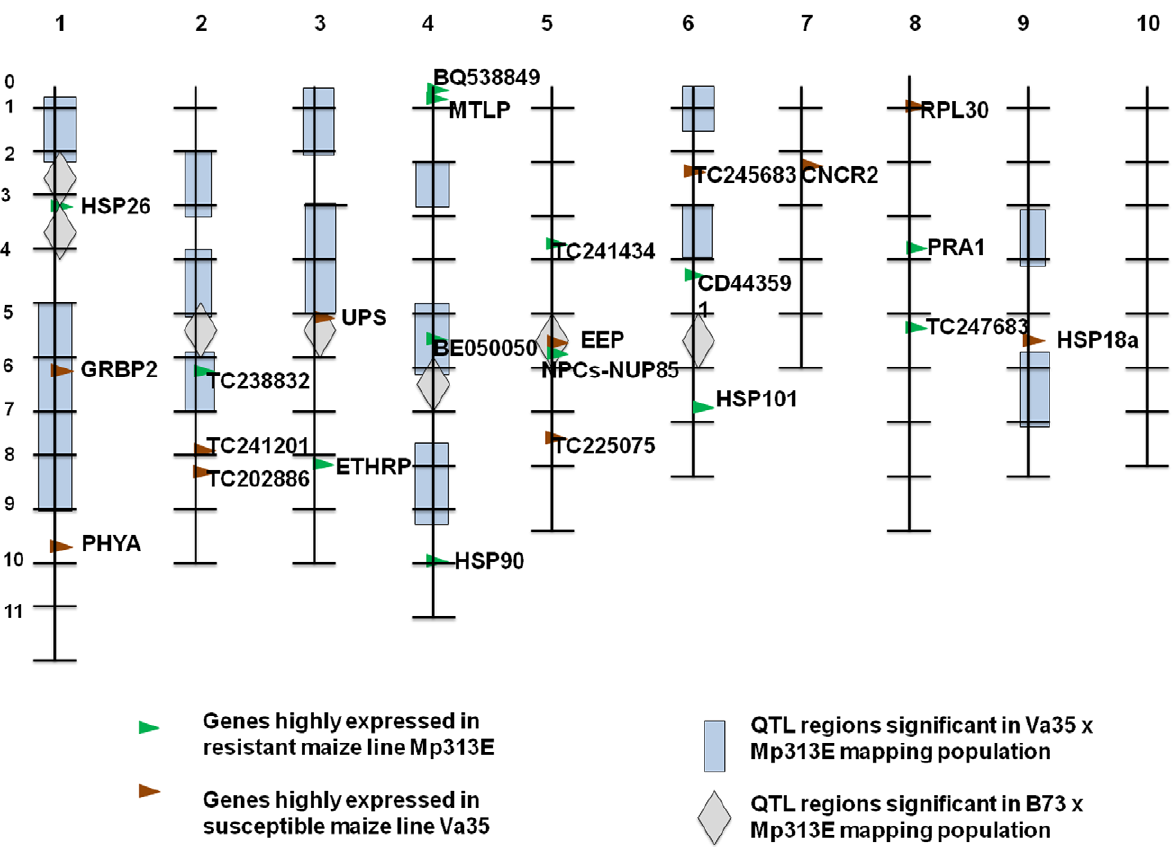
Figure 7. Chromosome bin map showing the positions of the significant genes and the previously identified QTL regions. Eight genes were mapped within or close to the seven most significant QTL regions. The top highly expressed gene in Va35, AI664980 (Chr1, bin1.06), is located in the most significant chromosome 1 QTL region (Chr 1, bin 1.5–1.9) identified from the Va35 x Mp313E population. The top highly expressed gene in Mp313E, TC231674 (Chr 5, bin 5.05), is mapped to the chromosome 5 QTL region (Chr 5, bin 5.05) identified from B73 x Mp313E population.